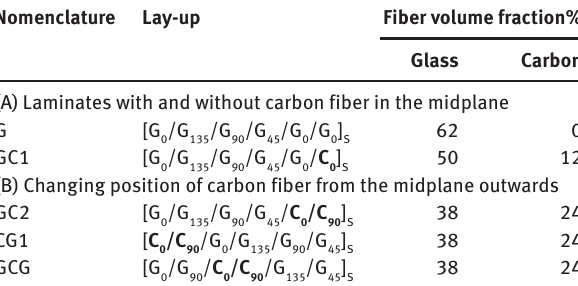
Table 1: Layer configuration of the composite